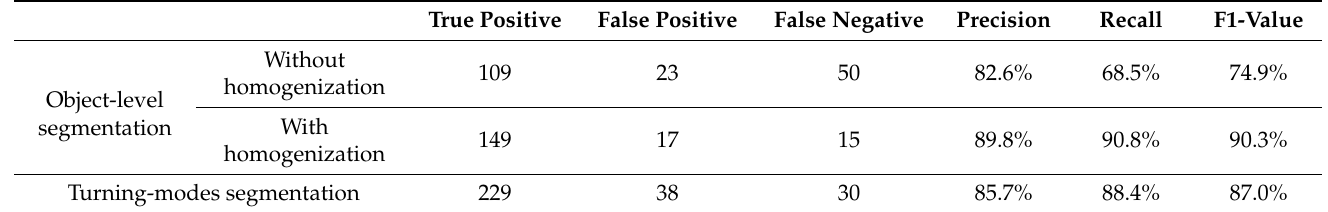
Table 3. Accuracy statistics of road intersections and turning modes